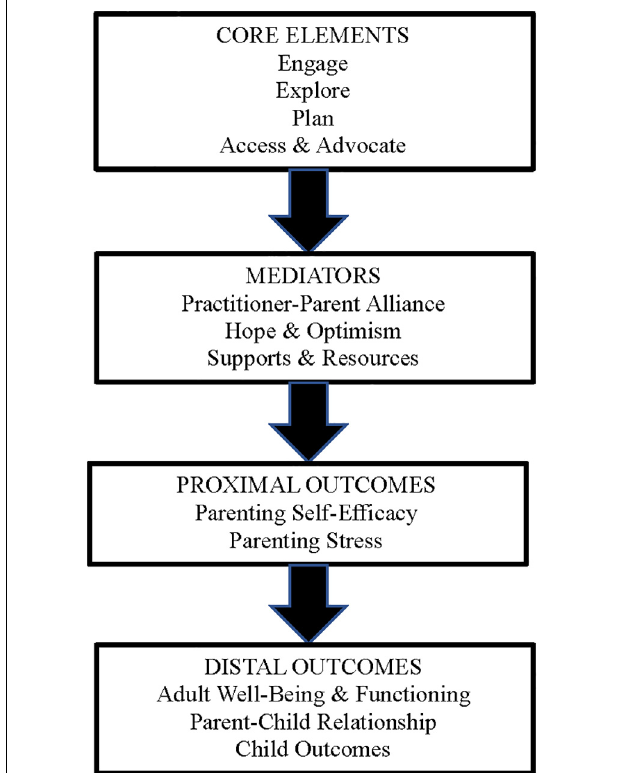
FIGURE 1 | The ParentingWell program theory is based on Self-Determination Theory (46) with core elements of Engage and Explore (autonomy: identifying personal circumstances and motivation, to feel and do better. Plan (competence: setting goals, assessing progress, and building self-efficacy), and Access and Advocate (relatedness: linking to natural and professional supports and